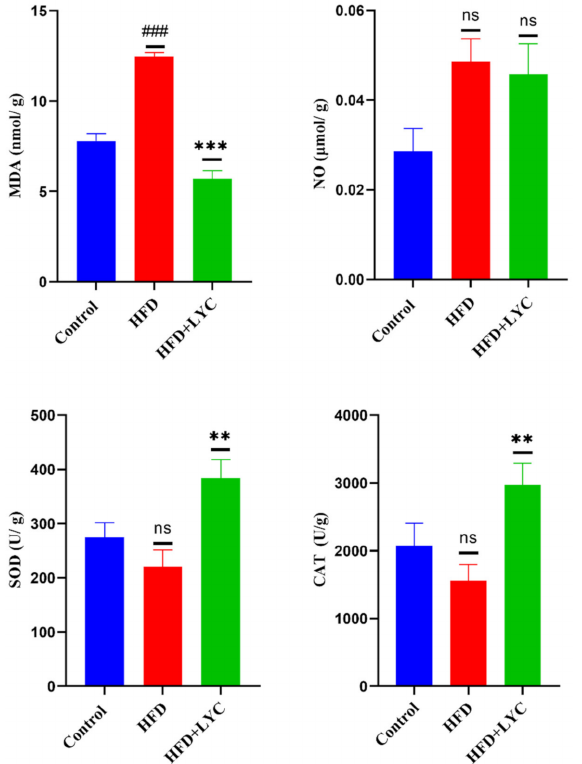
Figure 4. Hepatic levels of oxidative stress and antioxidant markers lipid peroxidation (MDA), nitric oxide (NO), superoxide dismutase (SOD), and catalase (CAT) following treatment with LYC in high-fat diet (HFD) rats. Data are expressed as the mean ± SEM of two replica ( n = 12 rats). Different markers correspond to statistically significant differences between groups. ### p < 0.001: very highly significant compared with the control. ** p < 0.05 and *** p < 0.001 indicate a highly significant and a very highly significant difference compared to the HFD group. ns: